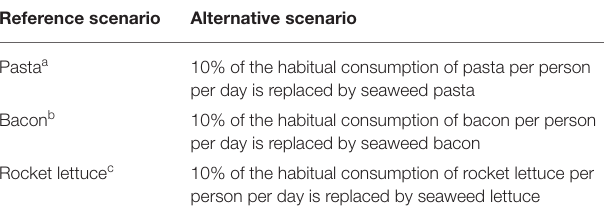
TABLE 1 | Scenarios of replacement of foods by seaweed-derived